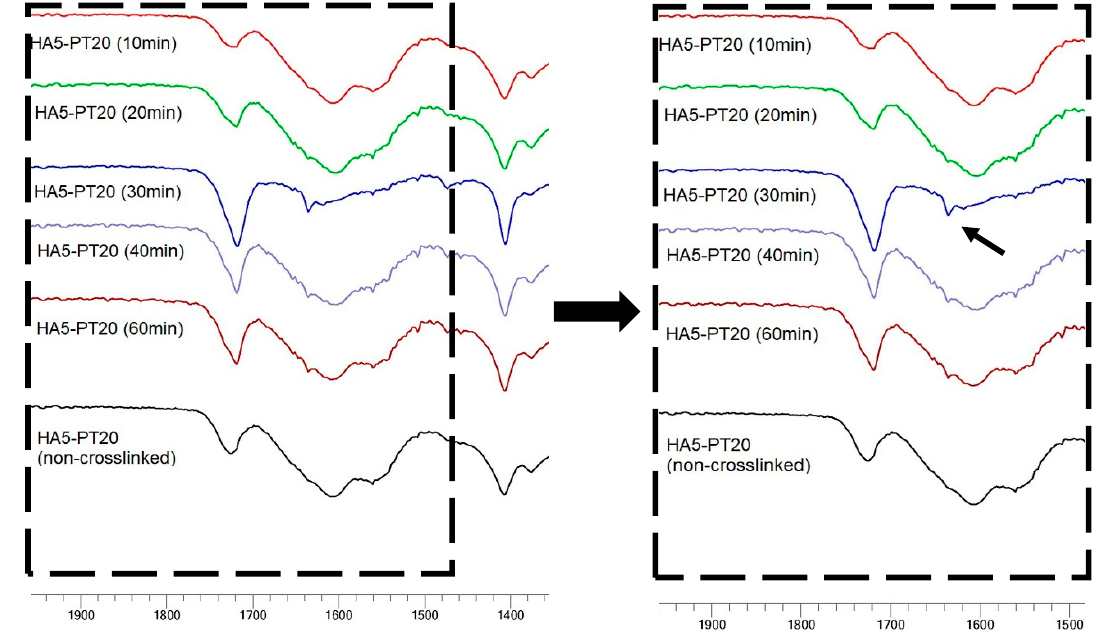
Figure 8. HA5-PT30 crosslinked by microwave irradiation (x-axis is the wavenumber/cm − 1 ). Cosmetics 2019 , 6 , 59